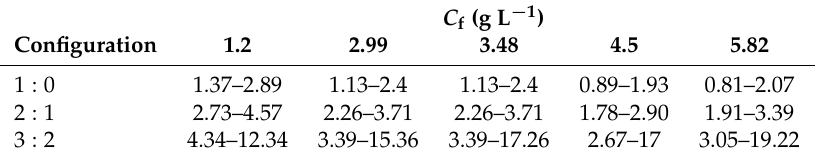
Table 2. P in (kW) range for different BWRO configurations and five C f (samples 20, 5, 22, 3 and 11 (Table 1)).